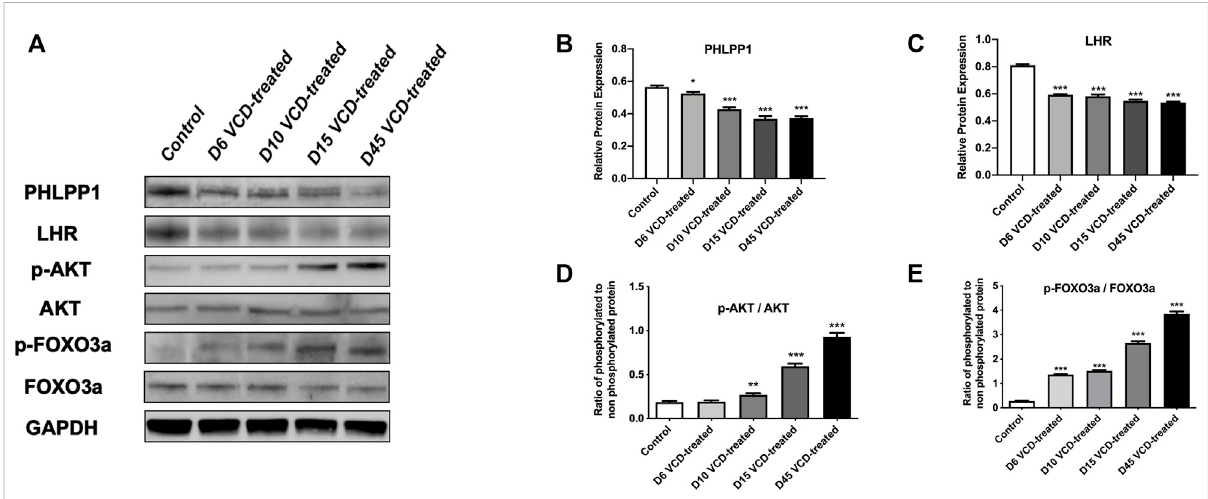
FIGURE 6 MiRNA-190a-5p targets PHLPP1 to regulate the protein expression levels of key genes on the primordial follicle hyperactivation signaling pathway. (A) Westernblotanalysis ofPHLPP1, LHR,AKT, p-AKT, FOXO3a, andp-FOXO3a during theVCD treating process (D6,D10, D15,andD45)in ratovariestissues.GAPDHwasusedasanegativecontrol. (B) and (C) ProteinanalysiscomparingtheconcentrationsofPHLPP1andLHRwithGAPDH usedasaloadingcontrol. (D) and (E) ProteinanalysiscomparingtheconcentrationsofphosphorylatedandtotalAKT,andFOXO3awithGAPDH used as a loading control, respectively. The ratio of phosphorylated to non-phosphorylated protein was calculated for each protein. Data are summarized and presented as mean ± SEM from four independent experiments. * p ＜ 0.05, ** p ＜ 0.01 and *** p ＜ 0.001 vs.